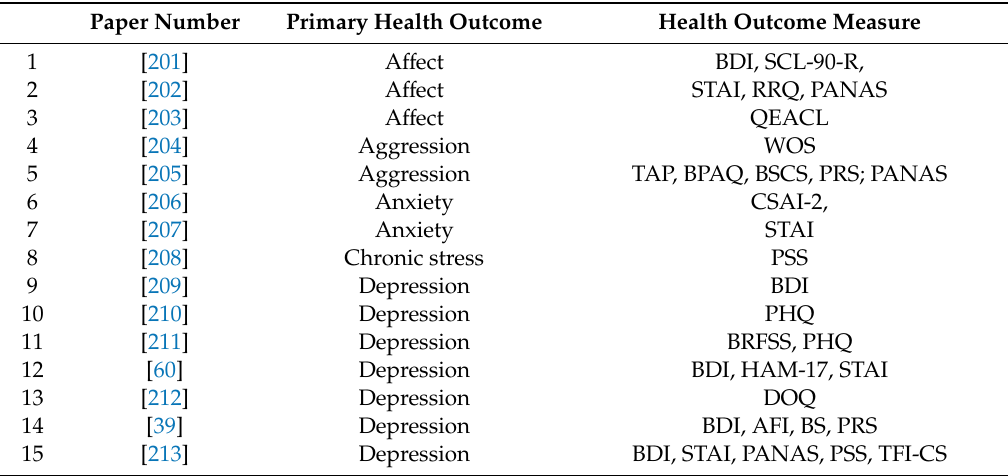
Table 8. Health outcome measure; the most commonly used tools included in studies assessing the associations between GS and mental